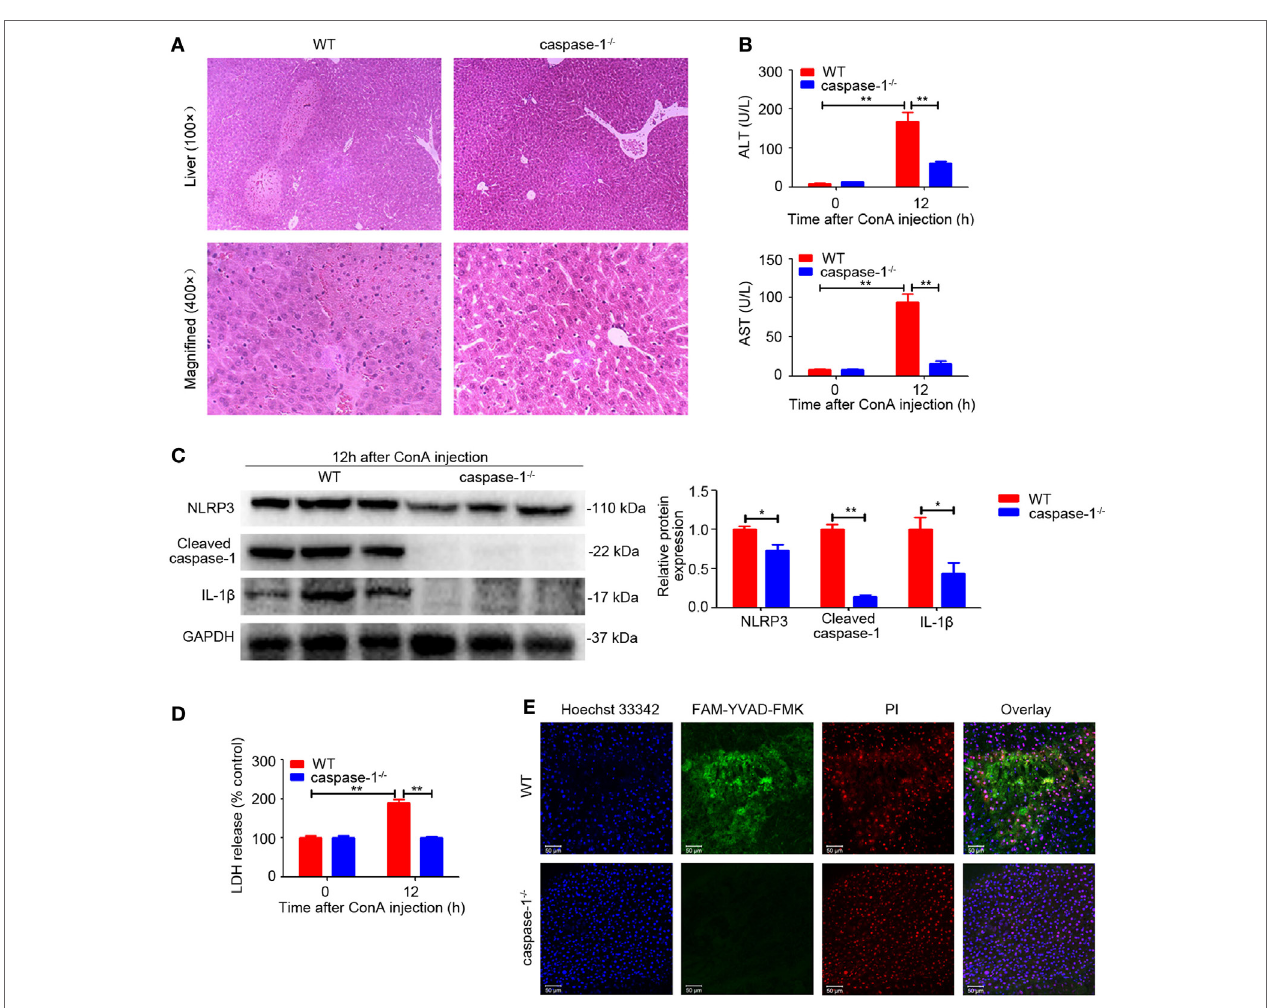
FigUre 3 | Caspase-1 deficiency suppressed ConA-induced hepatitis. (a) Caspase-1 − / − mice and WT mice ( n = 6 for each group) were subjected to ConA (20 mg/kg) treatment, and samples were collected after exposure to ConA for 12 h. Representative hematoxylin and eosin images of liver tissues were shown (100 × , magnification: 400 × ). (B) Serum ALT and aspartate transaminase (AST) levels were analyzed. (c) Western blot analysis of NOD-like receptor protein 3, Cleaved caspase-1 and IL-1 β in the livers. Densitometric quantification were normalized to GAPDH. Each lane represented a separate animal. Data shown represented three independent experiments. (D) Lactate dehydrogenase (LDH) release into serum was measured as signs of pyroptosis. (e) Pyroptosis in the livers was observed by confocal fluorescence microscopy. FAM-YVAD-FMK (green), propidium iodide (red), Hoechst 33342 (blue). The data were presented as means ± SD (Student’s t -test, * p < 0.05, ** p <